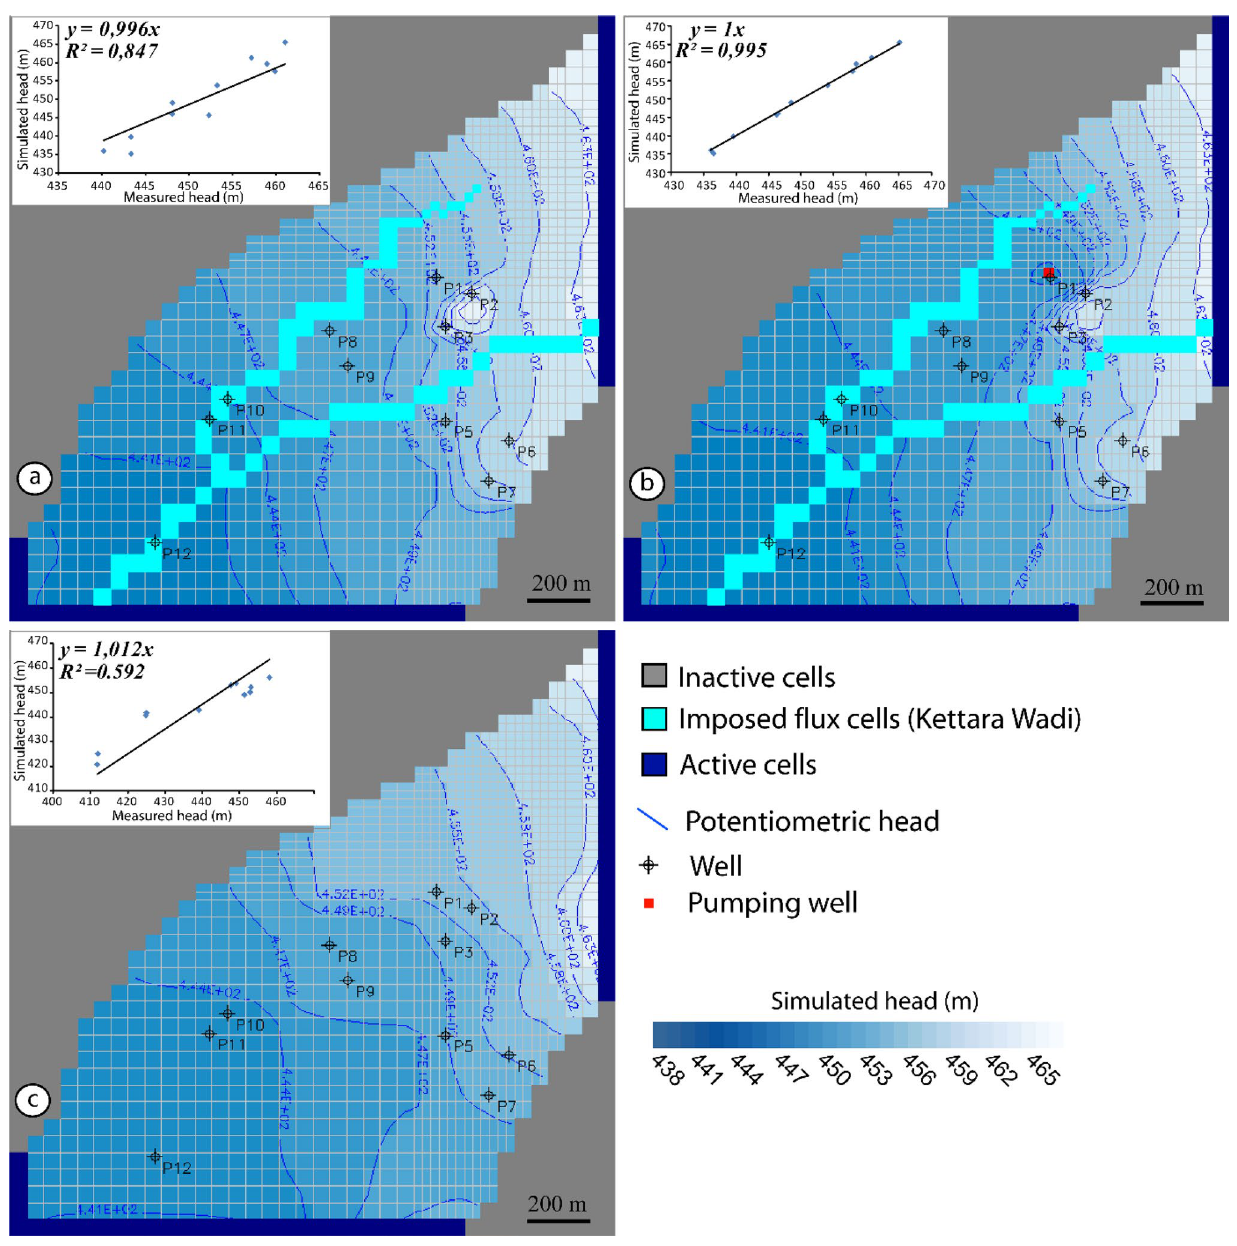
Fig. 7 Piezometric maps simulated in steady-sate flow a wet saison, c dry saison and in transient flow b wet